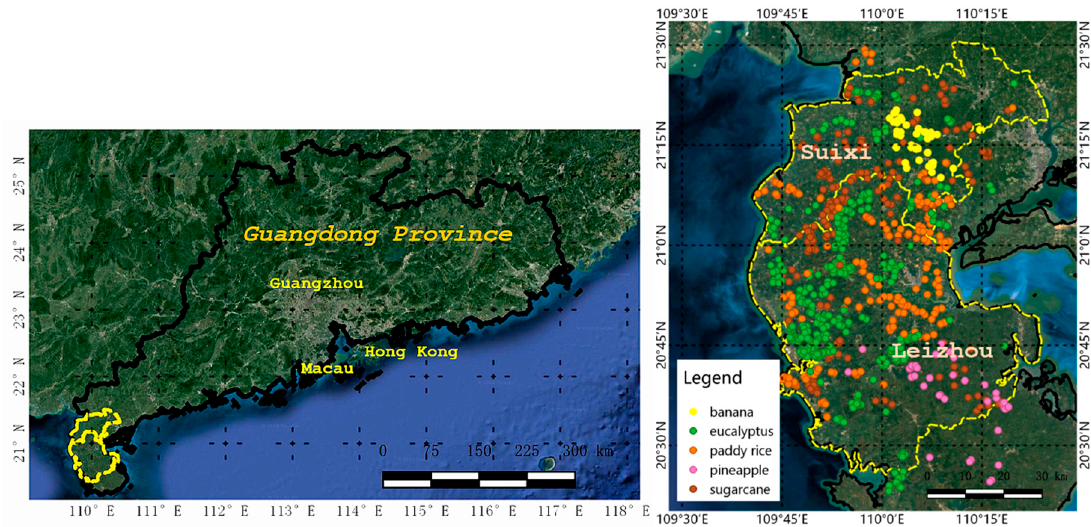
Figure 1. Study area and sample distribution.